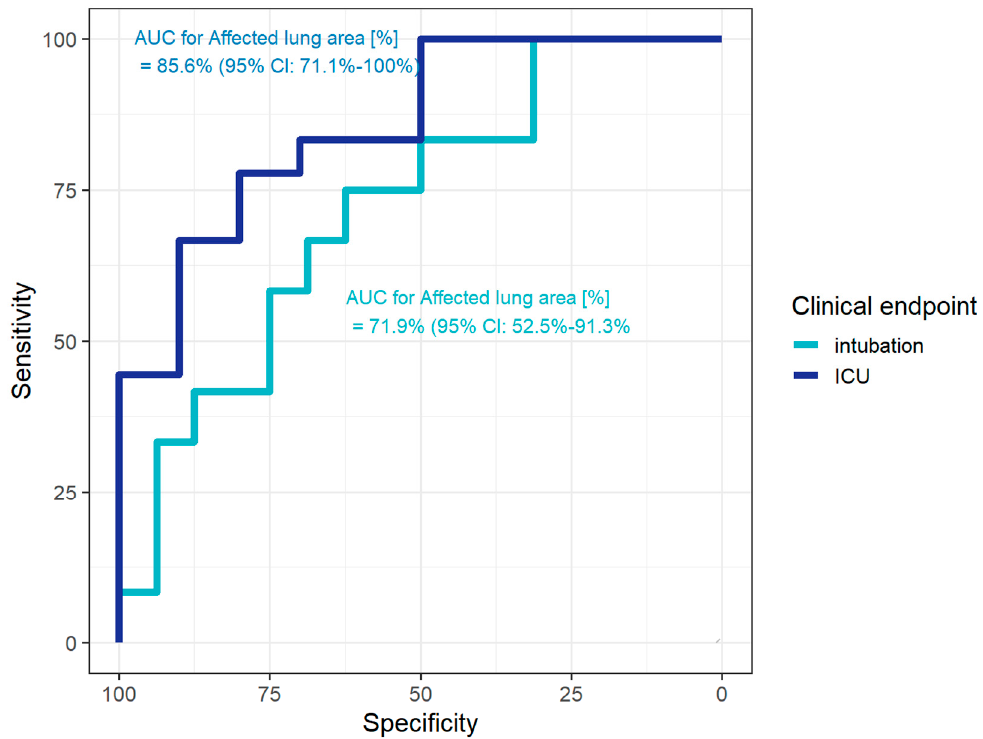
Figure 4. Receiver operating characteristic (ROC) curves to evaluate the diagnostic performance of affected lung area (%) for prediction of intensive care unit (ICU) treatment or intubation in patients with COVID-19. For the endpoint of ICU treatment (dark blue), the area under the curve (AUC) is 85.6% (95% CI: 72.1–100%). For the endpoint of intubation (light blue), the AUC is 71.9% (95% CI: 52.5–91.3%).